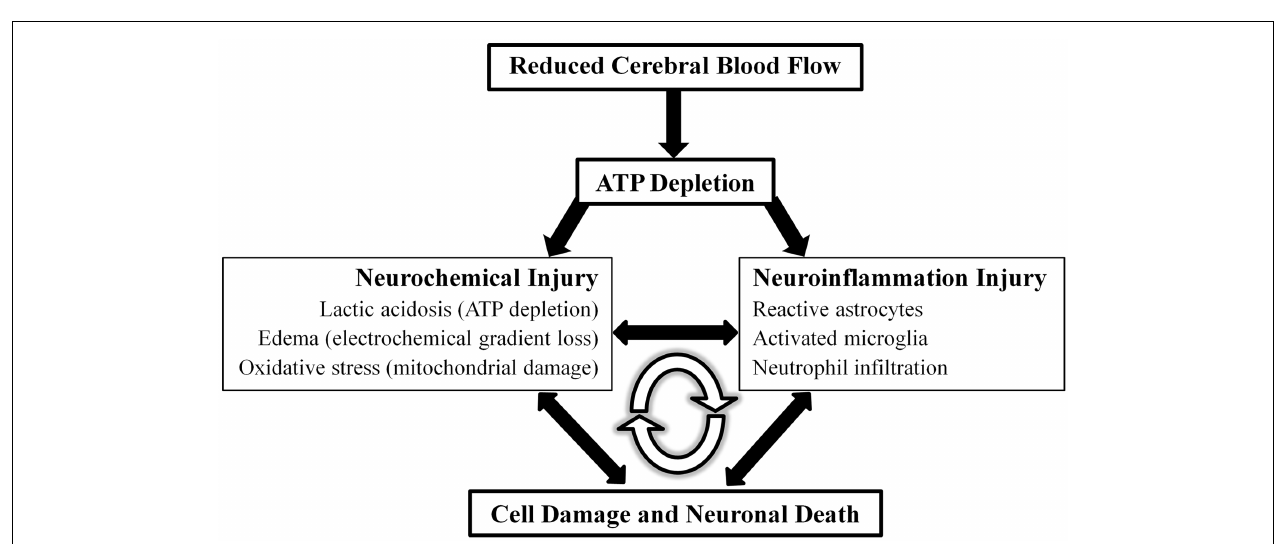
FIGURE 2 | Model of ischemic stroke acute pathophysiology . Detrimental acute effects of ischemic stroke can be conceptualized into two separate but highly inter-related physiological entities, neurochemical and neuroinflammation injury, that ultimately lead to cellular damage and death.These detrimental effects function in a positive feedback loop.